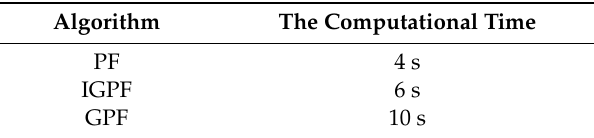
Table 6. Comparison of the computational